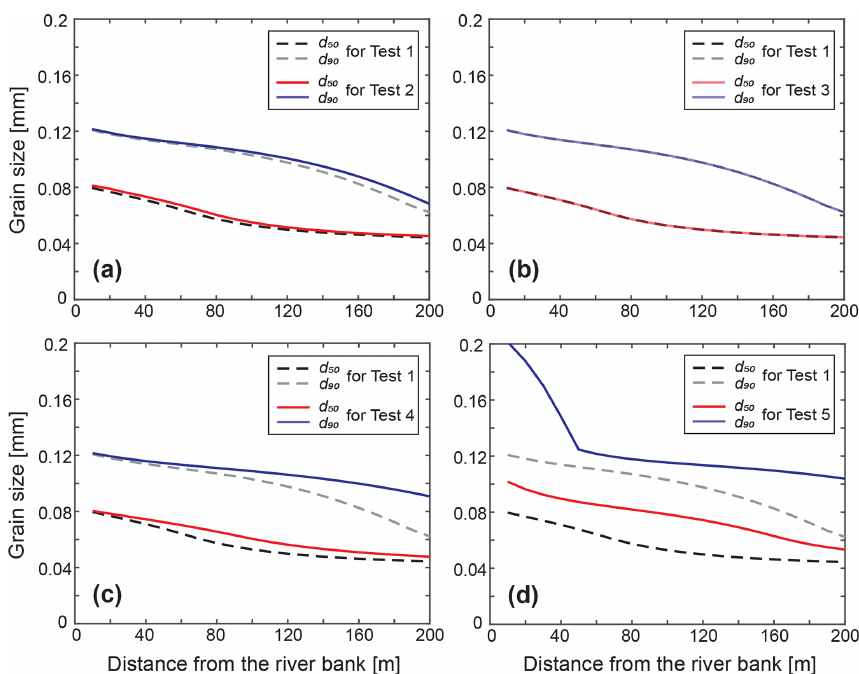
Figure 5. The grain-size ( d 50 and d 90 ) curves for the predicted levee deposits as a function of the distance from the channel-floodplain boundary. The two solid lines (red and blue) represent d 50 and d 90 for each test and the dashed lines (black and gray) are for Test 1,